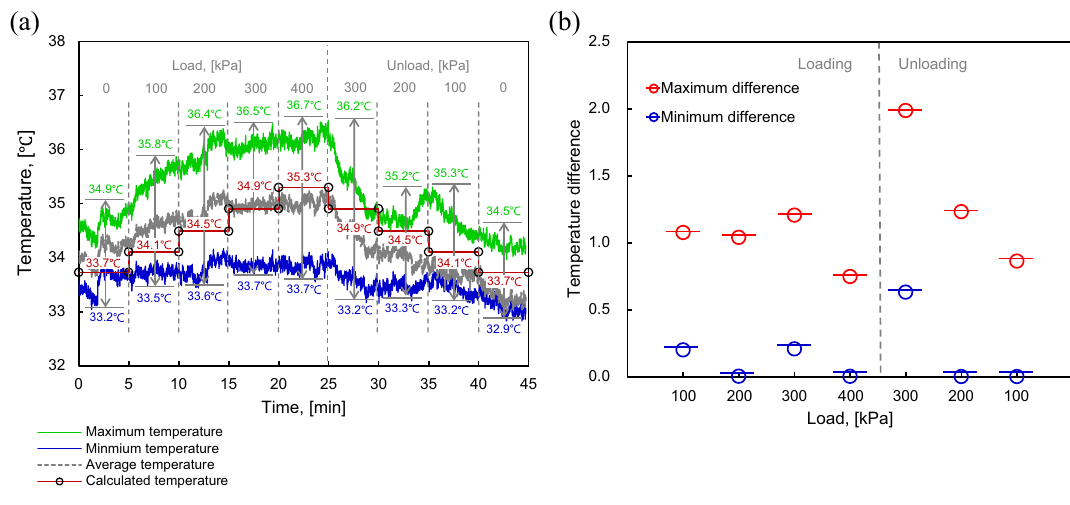
Figure 10. Distribution of measured temperature in the passive method: ( a ) maximum, minimum, and averaged temperatures; ( b ) temperature difference according to each